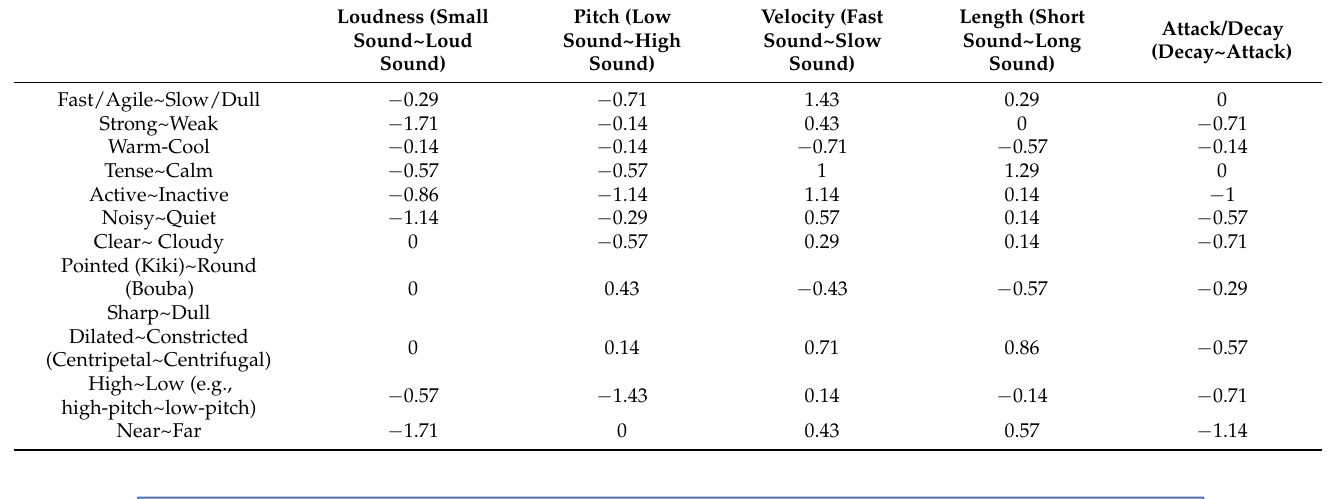
Table 7. Matching results of sound variables with adjective pairs.